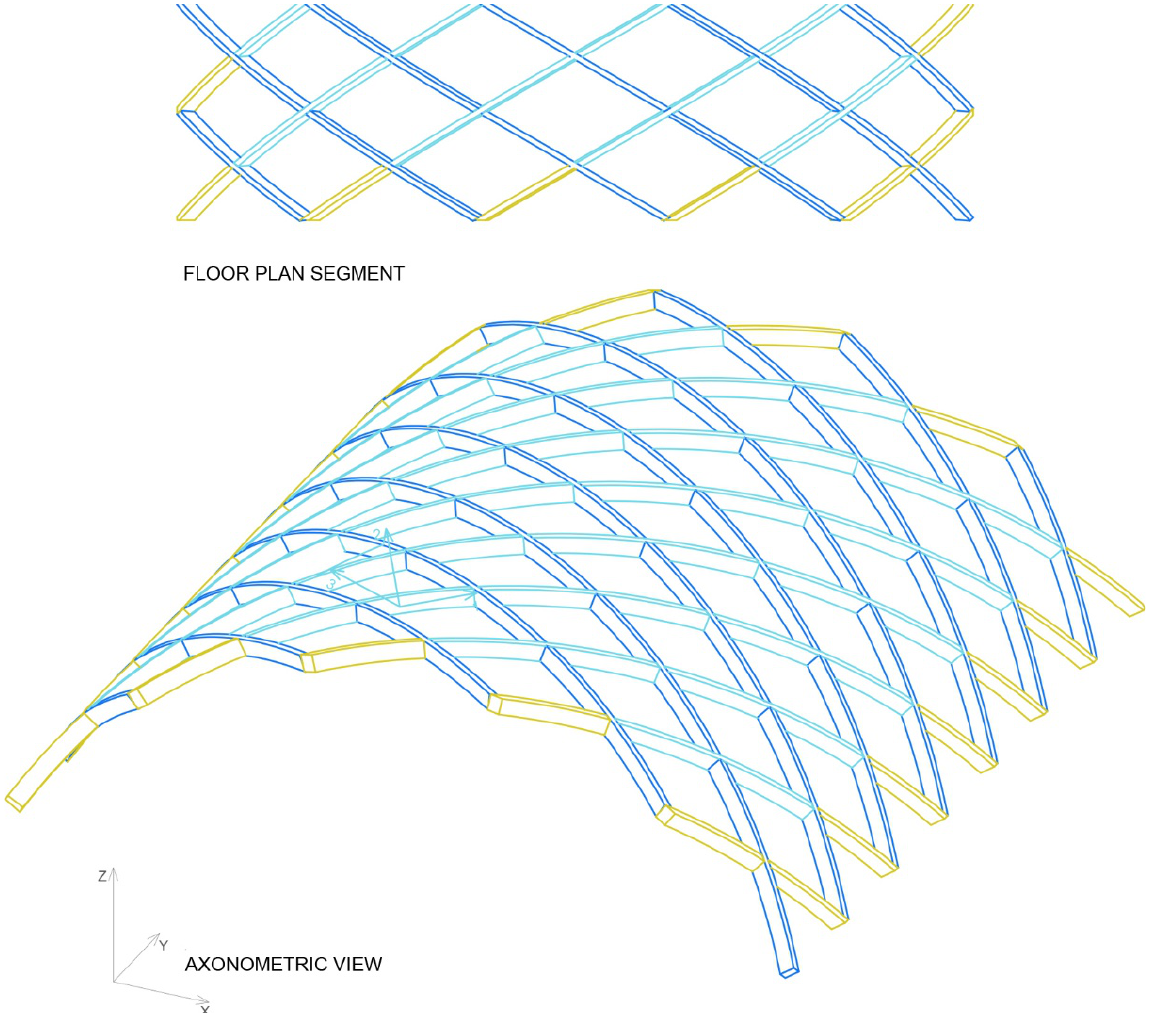
Figure 3. The lamellae for a timber lamella vault where all the axes of the lamellae intersect in the node. The curve of the lamellae axis is the same for all the lamellae, and the length differs on the perimeter (yellow lamellae). The colors of the lamella show the different types of lamellae.